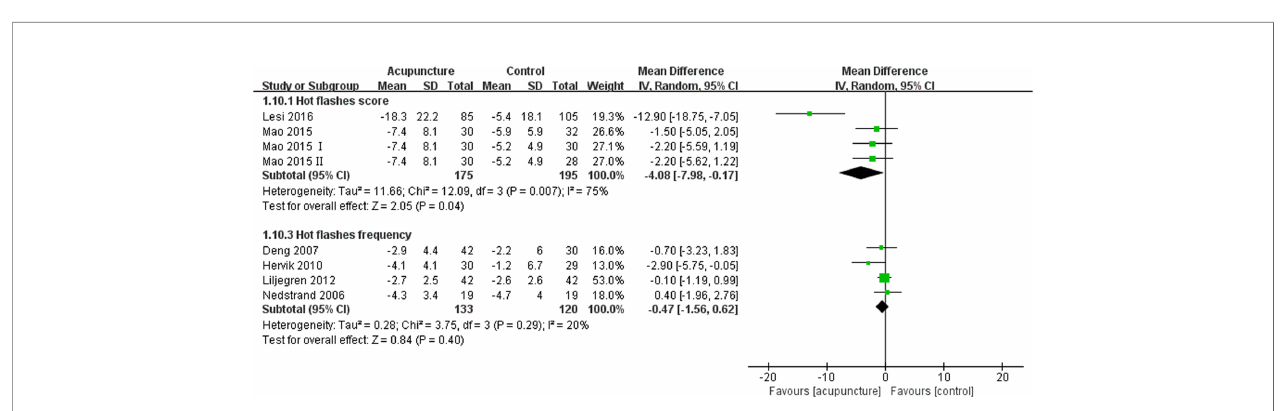
FIGURE 3 | Forest plot of the change of hot fl ashes in BC patients treated with acupuncture and control from the bassline to end of treatment. IV, inverse variance; CI, Con fi dence Interval. The Roman numerals “ I ” and “ II ” followed the study ID represented the comparison of acupuncture versus no intervention and the comparison of acupuncture versus western medicine, respectively, in the study which had four